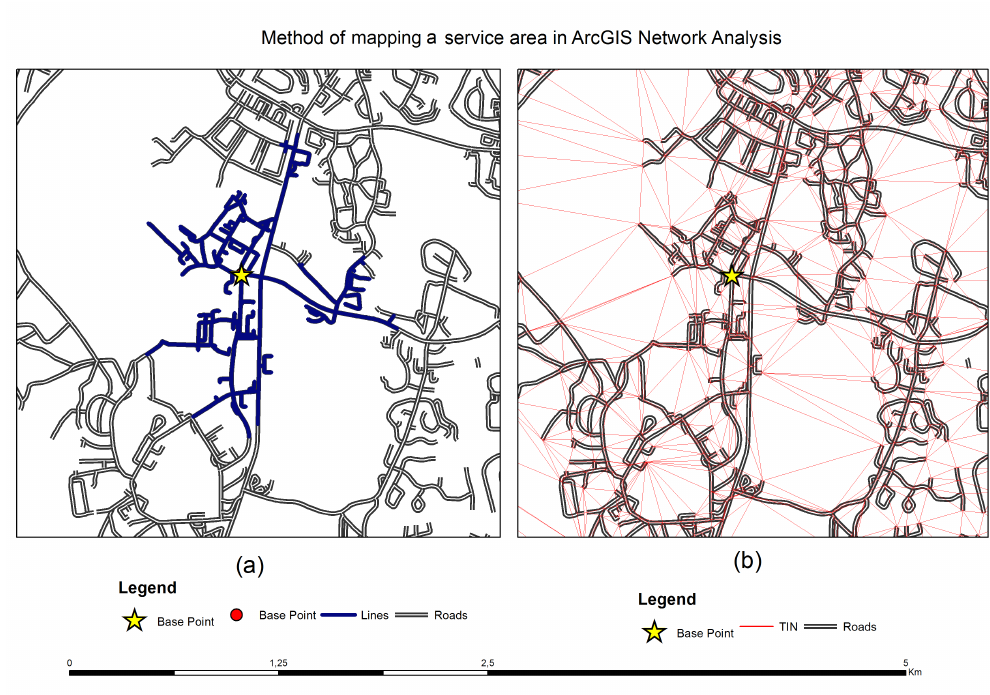
Figure 1. Generation of service areas: ( a ) the effective reach of the road network from a base point at a given cost, ( b ) a Triangulated Irregular Network (TIN) developed based on road network